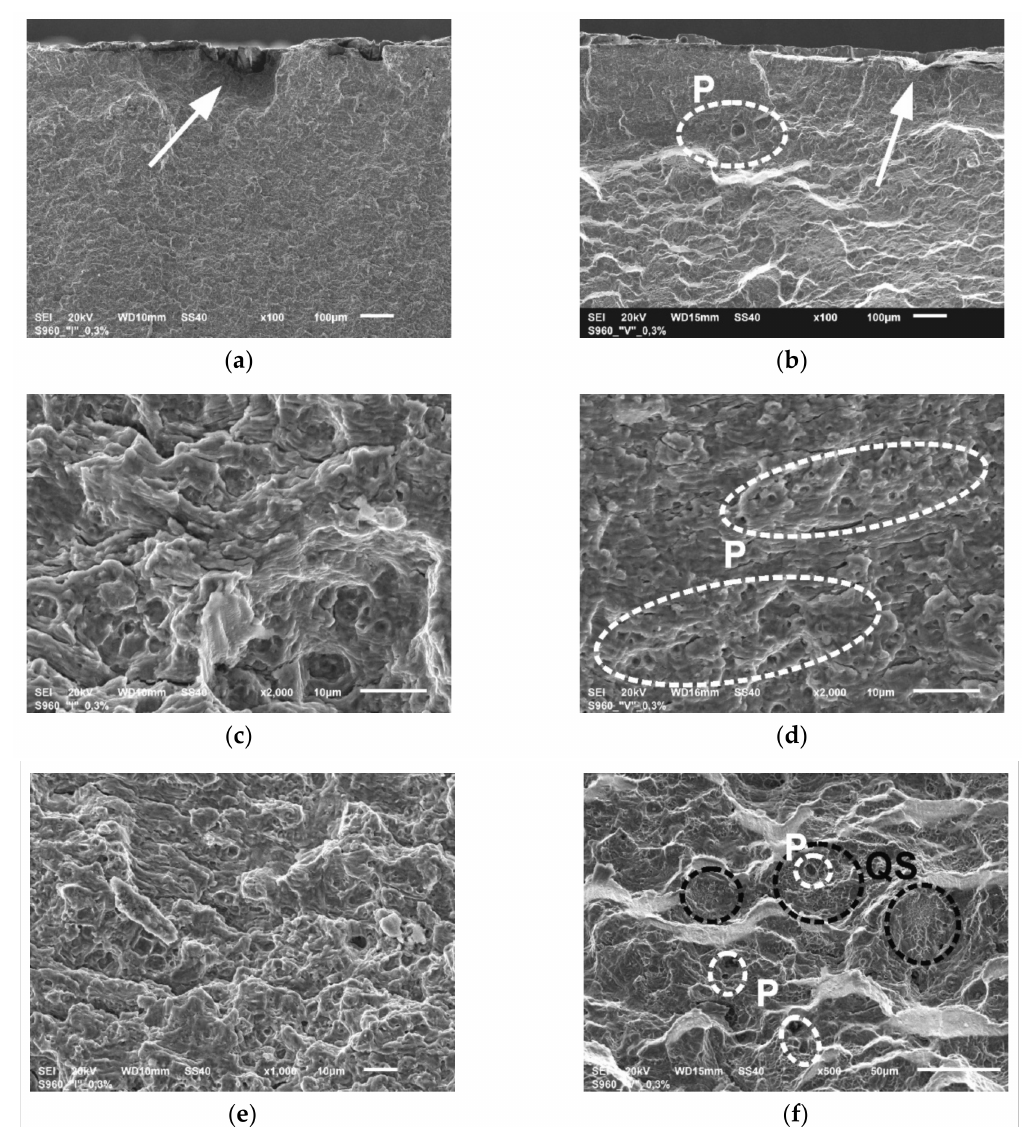
Figure 12. The details of fatigue fractures of WJ tested at ε ac = 0.3%: ( a ) the region of initiation in sample WJ-S; ( b ) the region of initiation in sample WJ-V; ( c ) the stage of stable crack growth in sample WJ-S; ( d ) the stage of stable crack growth in sample WJ-V; ( e ) the stage of rapid crack growth in sample WJ-S; ( f ) the stage of rapid crack growth in sample